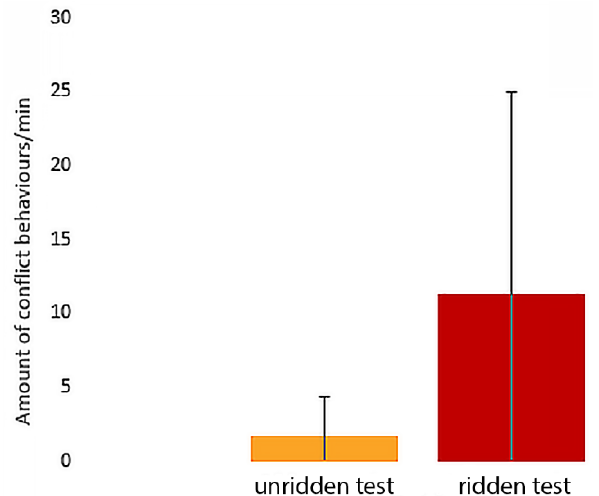
exercises (11 ± Figure 8. Mean number of observed conflict behaviours per minute in the unridden (2 ± 3) and ridden exercises (11 ± 14).